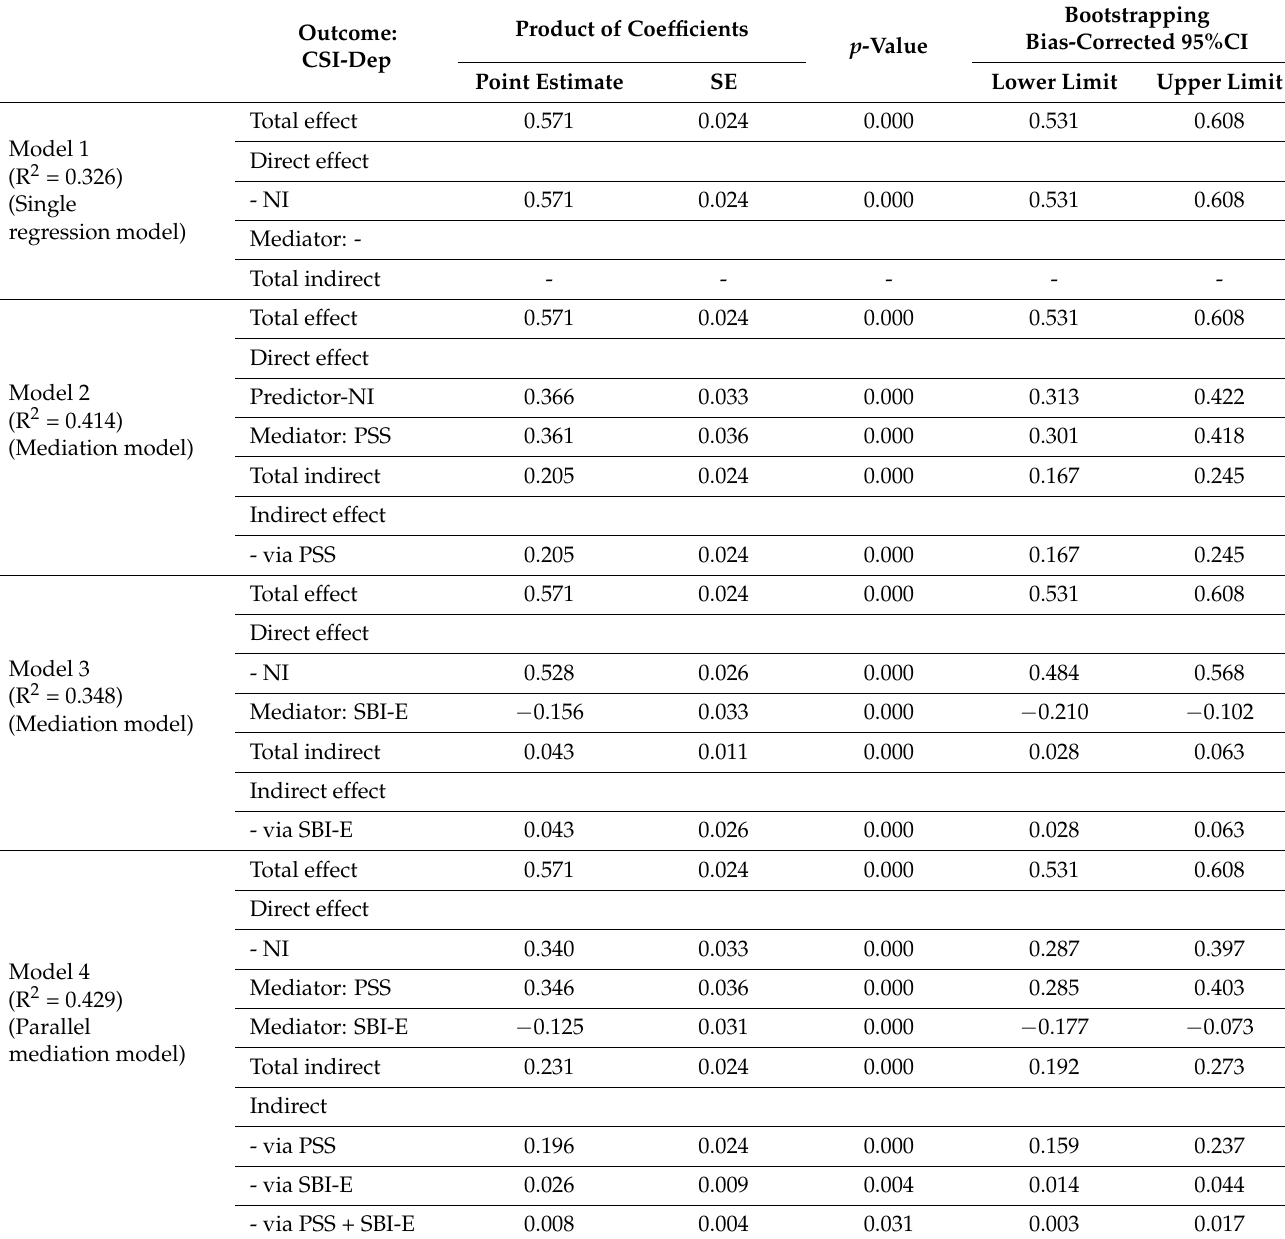
Table 3. Mediation Effect of level of Perceived Stress and Equanimity on the Relationship Between level of Neuroticism and Depressive symptoms controlling for age, sex and